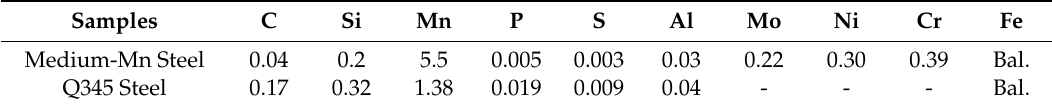
Table 1. Chemical compositions of the specimens (in mass